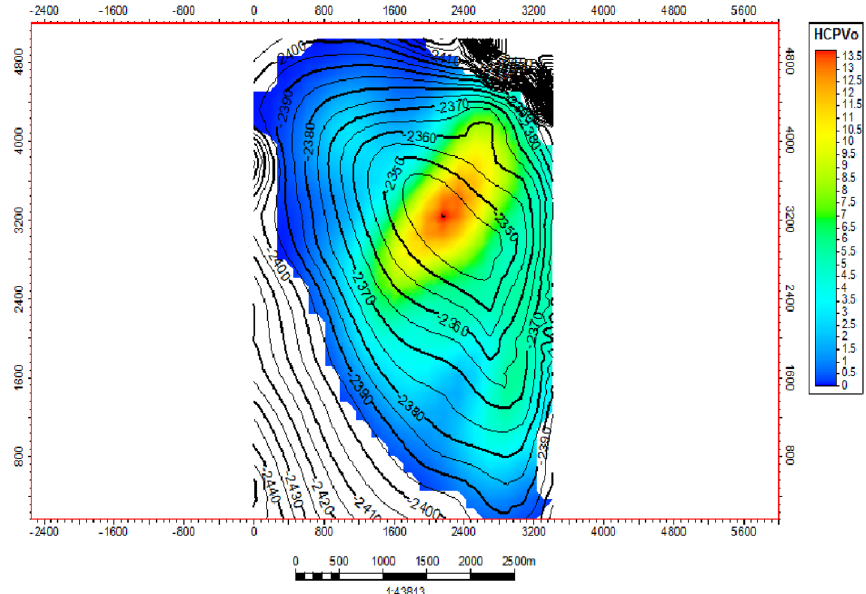
Fig. 4 Hydrocarbon pore vol- ume map showing oil saturation at various